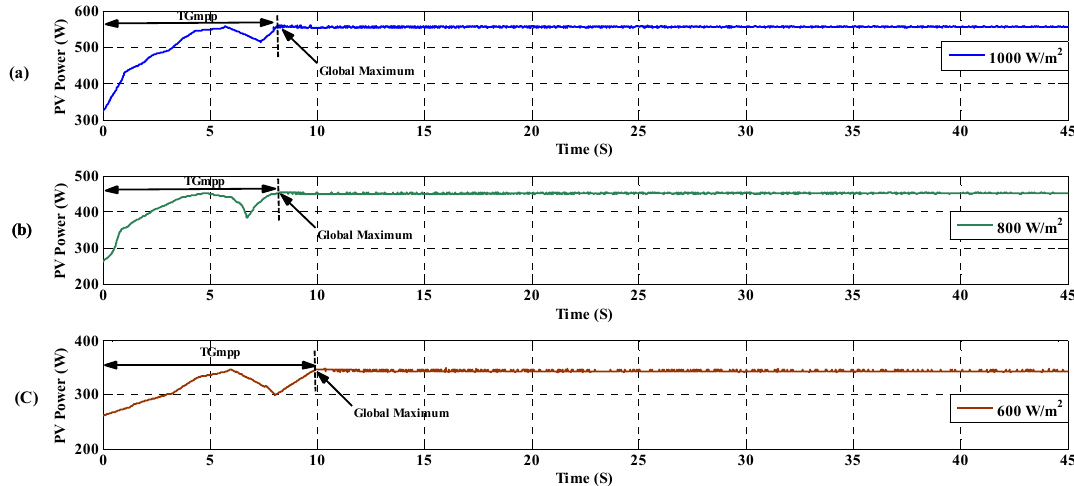
Figure 25. PV output power for the scenario in Figure 24 for irradiations of ( a ) 1000 W/m 2 ; ( b ) 800 W/m 2 and ( c ) 600 W/m 2